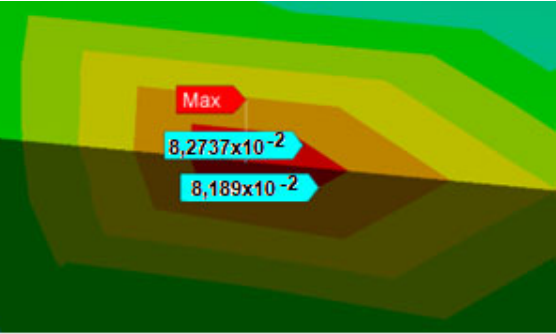
Figure 13. Example of maximum and evaluated HMH stress (MPa) (Tantum 125° healed femur).